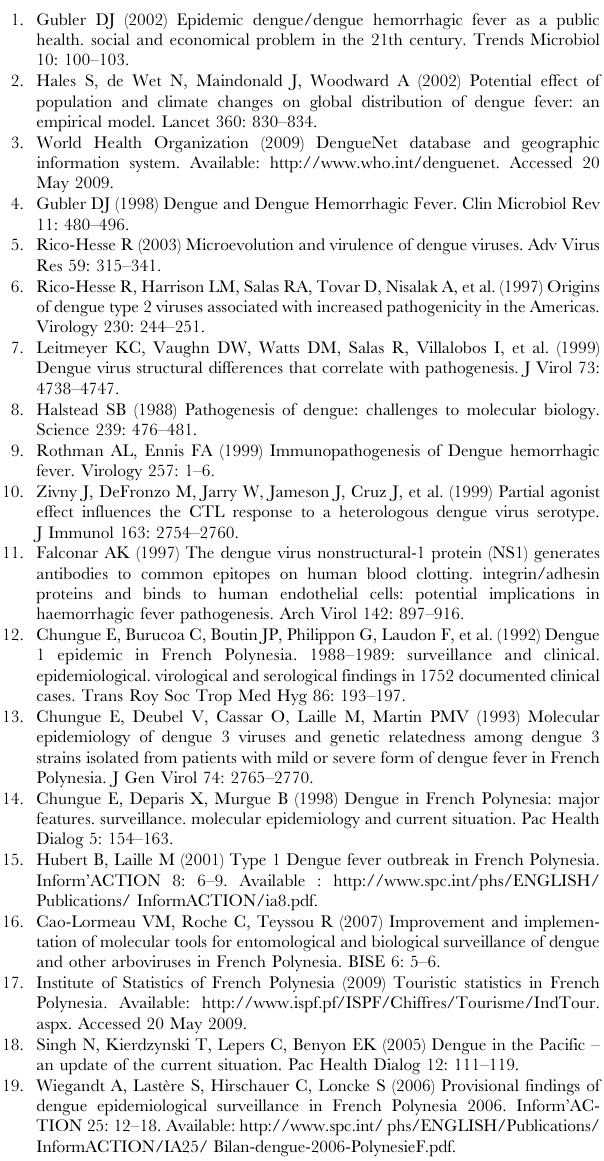
Figure S2 Phylogenetic tree based on 53 nucleotide sequences of complete coding region of DENV-1 (Neighbor-Joining method, Kimura 2 algorithm). Taxon names of FP sequences correspond to D1.FP/sample number.year (month, geographical origin, clinical presentation). Taxon names of GenBank sequences correspond to D1.country/last two digits of year of isolation and GenBank accession number. In this condensed tree, branch length is not proportional to genetic distance. Numbers on branches represent bootstrap support for each branch. Table S1 Primers used for DENV-1 amplification and sequenc-